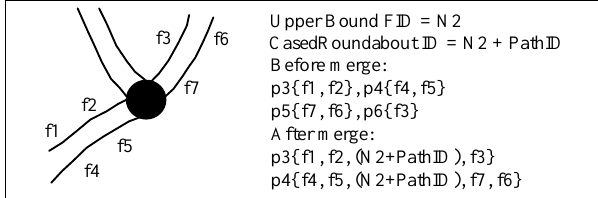
Figure 6. Extended graph